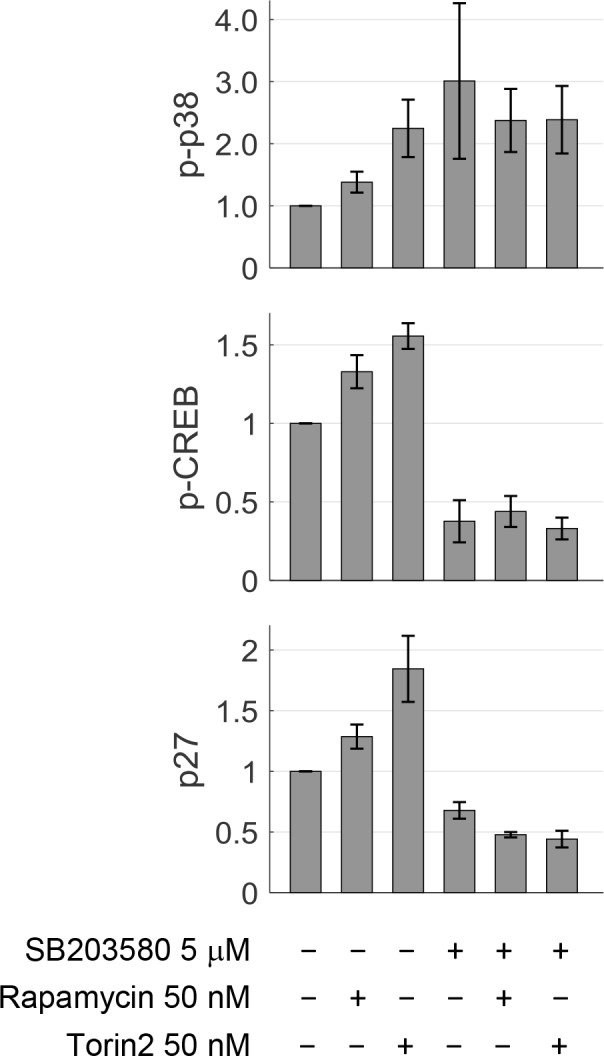
Quantification of p-p38, p-CREB and p27 in conditions shown Figure 2C.The bar plot and error bar display mean and SEM across three replicate Western-blot experiments. Treatment of rapamycin or Torin-2 increases both p-p38 and p-CREB, confirming that activity in the p38 pathway is upregulated under mTORC1 inhibition. SB203580, a p38 inhibitor, significantly reduces the phosphorylation of CREB (downstream of p38), confirming that p38 activity is inhibited. p27 is a negative regulator of G1 progression. mTOR inhibition by rapamycin or Torin-2 upregulates p27 activity, which promotes a longer G1. Strikingly, cells co-treated with p38 inhibitor and mTOR inhibitor have lower p27 compared to treatment of p38 inhibitor alone. This may be the mechanism by which p38 inhibition disturbs the cells’ ability to compensate their small size with longer G1.